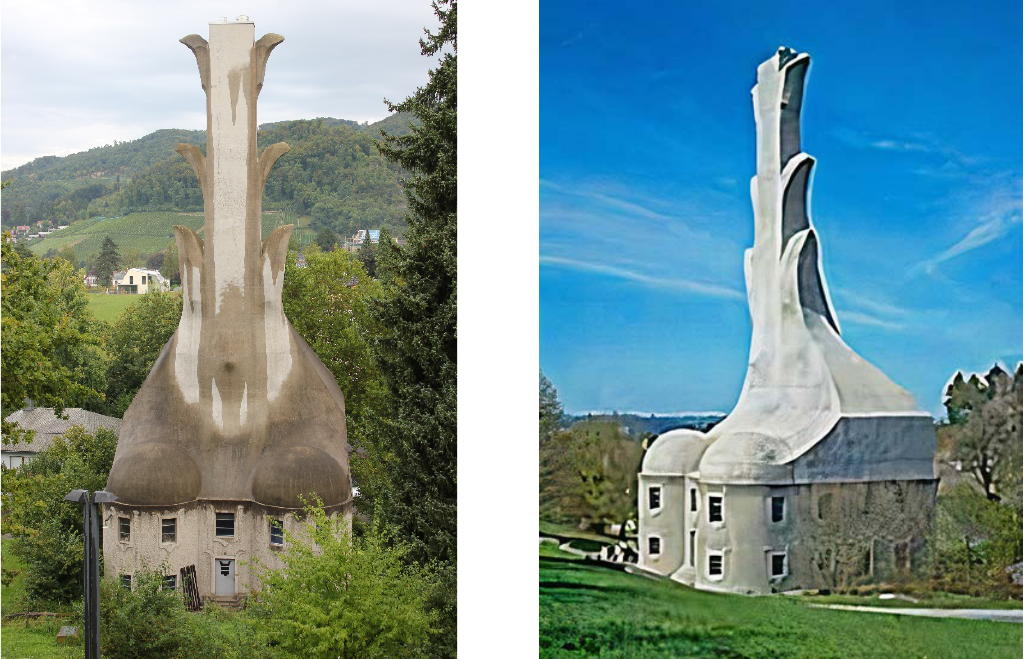
Figure 4. The boiler room (1915) [19,30].